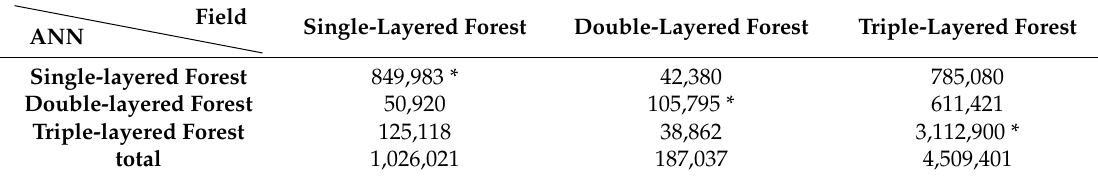
Table 2. Validation of forest vertical structure classified by using the ANN